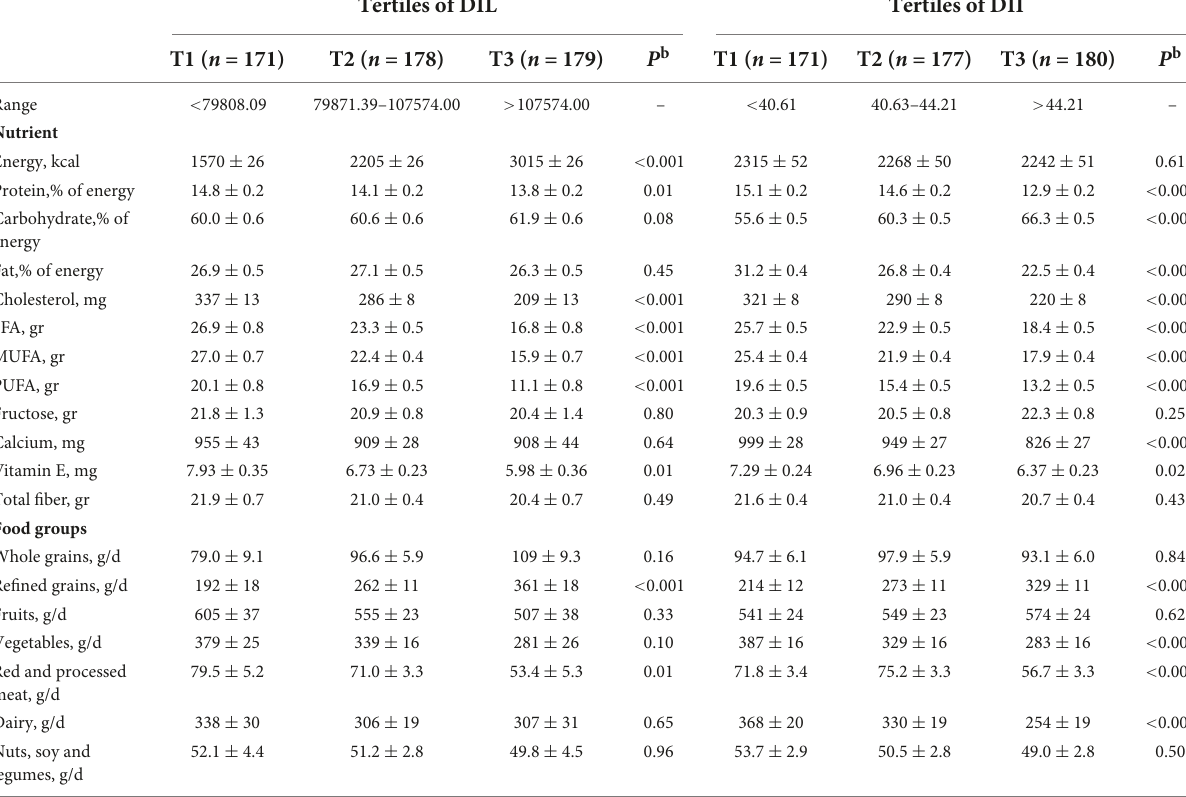
TABLE 2 Dietary intakes (energy, macro/micro nutrients and food groups) of study participants across tertiles of DIL and DII a . Tertiles of DIL Tertiles of